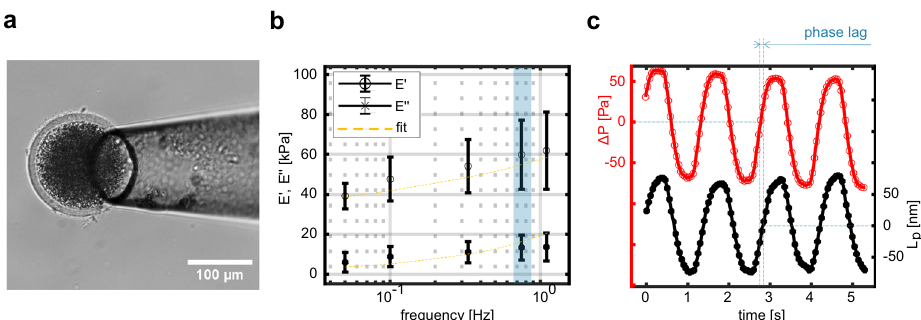
Fig. 3 DMA of the Zona Pellucida of mature bovine oocytes. a Image of an oocyte captured by the measurement probe. The thin, semitransparent membrane around the cell is the Zona Pellucida. Its thickness, measured via image analysis, was about 10 µ m for all the tested oocytes. It is worth noting that, since the displacement is measured via the fi ber within the capillary, the probe does not need to be parallel to the petri dish. b The frequency dependency of storage and loss moduli of the Zona Pellucida, (mean ± SD, N = 10). The solid yellow line is the expected trend as a function of frequency, following the two terms power law behavior mentioned in the main text. c Variation of pressure ( Δ P) and aspirated length ( L p ) at 0.75 Hz, highlighting the phase lag between the